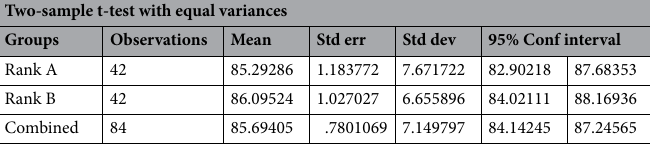
Table 5. Two-sample t-test with equal variances ƒ.